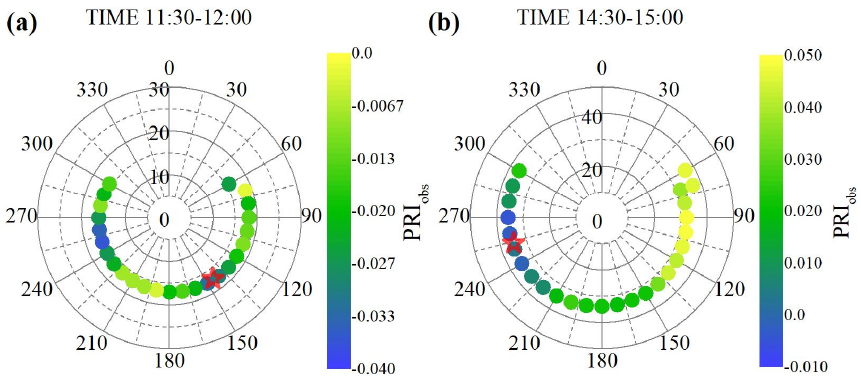
Figure 2. Photochemical reflectance index (PRI) observations in a polar coordinate system. The observed PRI (PRI obs ) were obtained at di ff erent view angles at a di ff erent time on Day of Year (DOY) 204 (23 July, 2018). The red pentagram represents the average solar position within the 30 min in the polar coordinate system delineated by solar zenith angle and solar azimuth angle. Azimuth angles are defined from geodetic north.